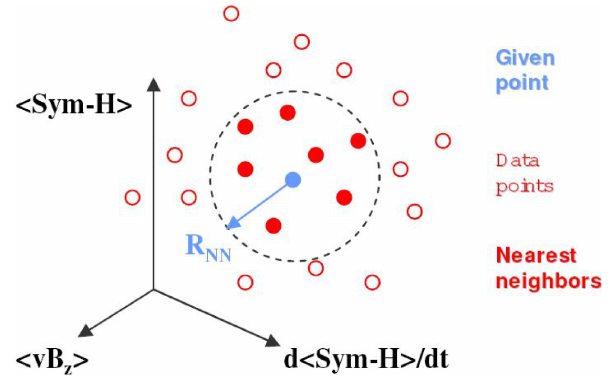
Fig. 9. Illustrates the “nearest-neighbour” selection of archived data into a binning sphere, drifting in the parametric space (Sitnov et al.,